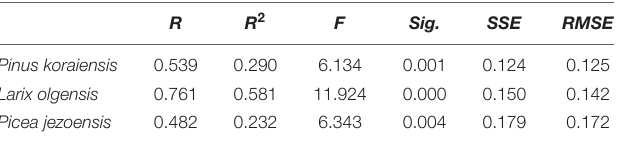
TABLE 3 | Statistics of equation for Pinus koraiensis , Larix olgensis , and Picea jezoensis . R R 2 F Sig. SSE